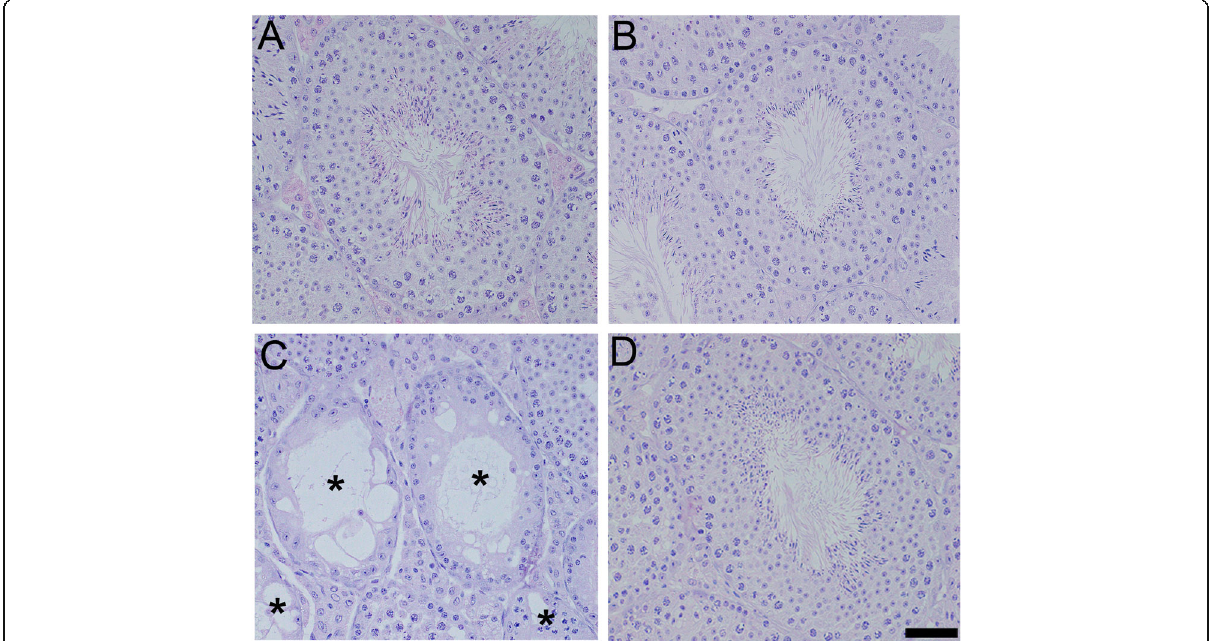
Fig. 2 Effect of TJ107 on testes histology after irradiation. Asterisks indicates the damaged seminiferous tubules with azoospermia in Group C c at day 120. However, in the Group D d , all stages of maturation of the germinal epithelium are seen in normal-appearing seminiferous tubules like in Group A a and Group B b . Bar = 50 μ m